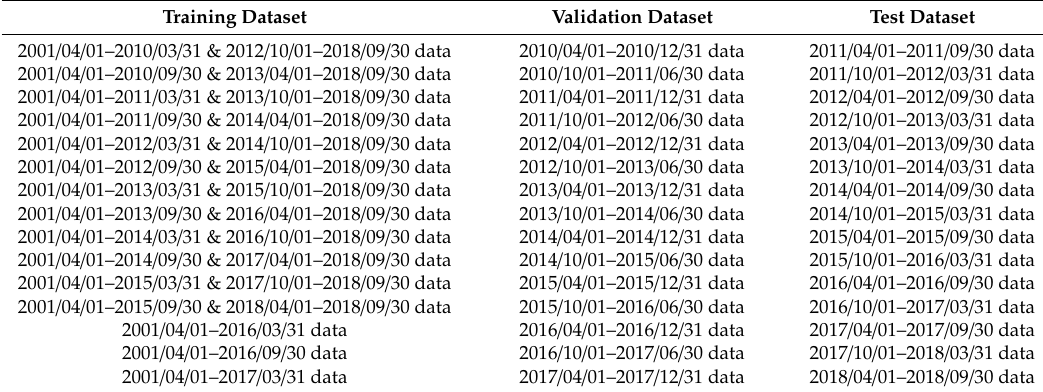
Table 3. Training dataset, validation dataset, and test dataset for repeatability